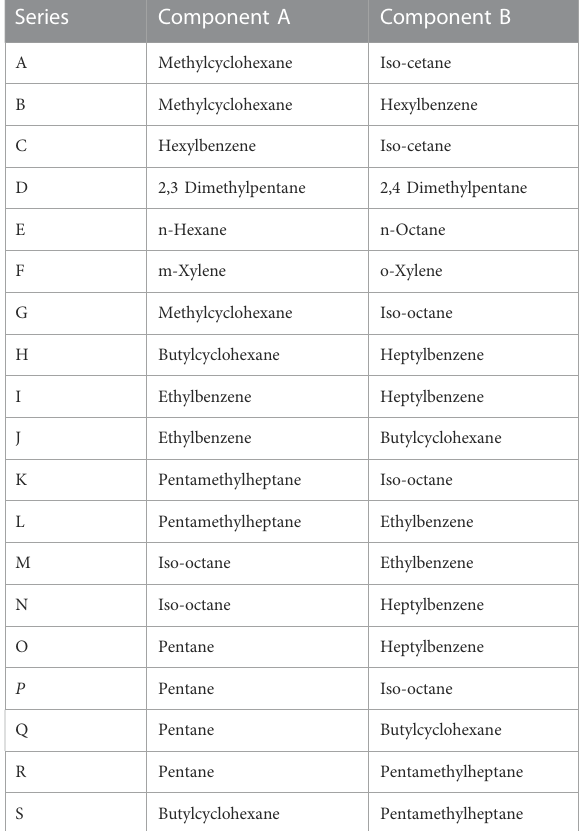
TABLE 4 Components of type A, binary